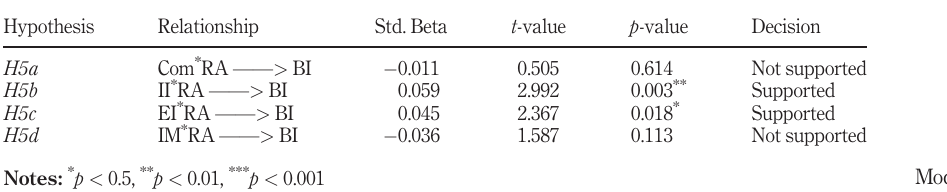
Table 6. Moderating